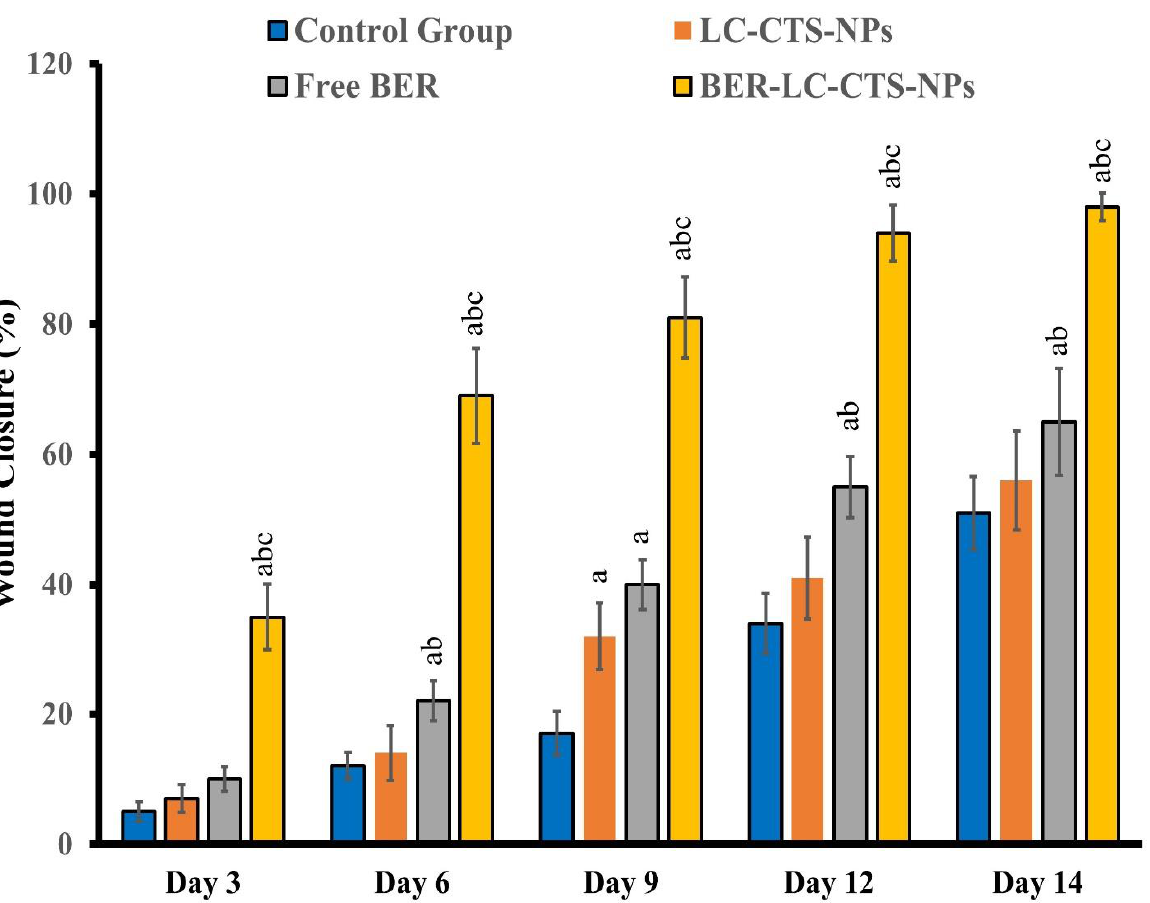
Figure 7. Percent wound closure rate of wound area in treated animals on the 3rd, 6th, 9th, 12th, and 14th day after wound creation in the diabetic rats of the untreated (Control), lecithin–chitosan nanoparticles without berberine (LC-CTS-NPs), free berberine (Free BER), and lecithin–chitosan nanoparticles containing berberine (BER-LC-CTS-NPs) groups. a illustrates a significant variation when compared to the Control group. b illustrates a significant variation when compared to LC-CTS-NPs group. c illustrates a significant variation when compared to Free BER group.